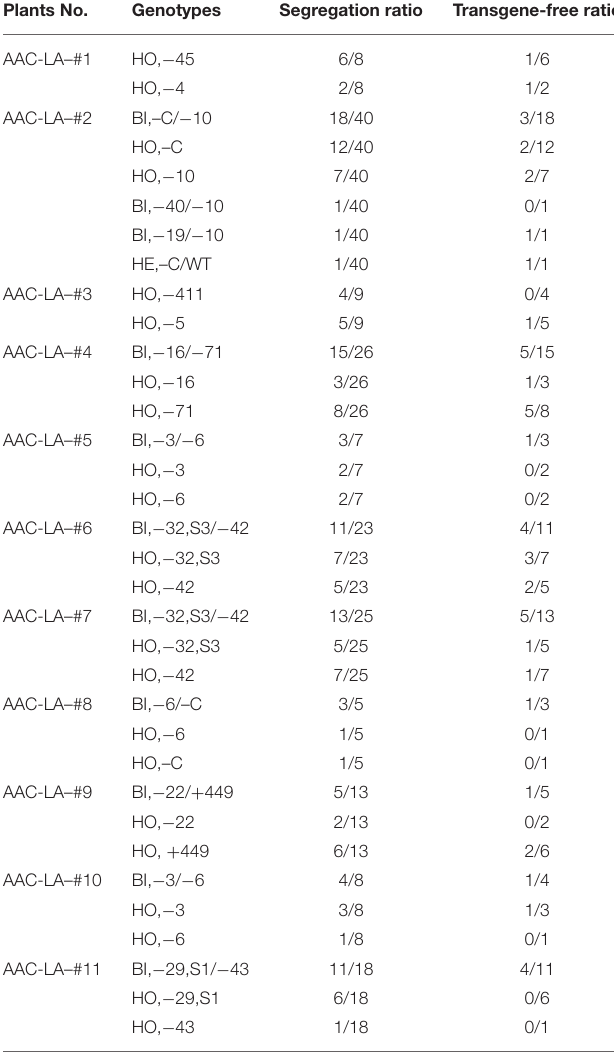
TABLE 1 | Genotypes and segregation patterns in the T1 plants generated from the AAC-LA. Plants No. Genotypes Segregation ratio Transgene-free